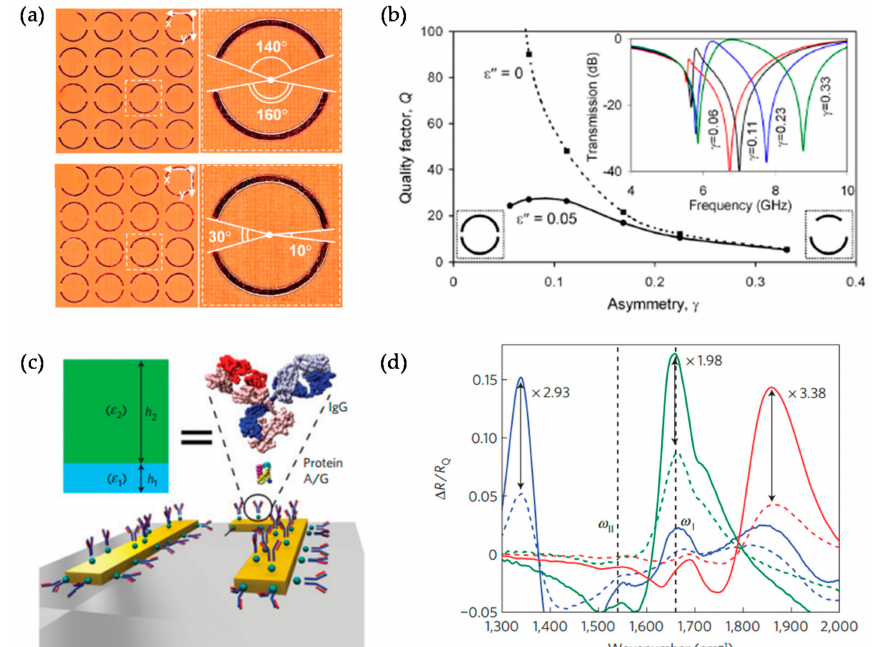
Figure 6. ( a ) Planar MMs with asymmetric split copper rings. The dashed boxes indicate unit-cell structure; ( b ) Quality factor of “trapped-mode” resonance as a function of the particle asymmetry γ , defined as the relative difference of the arcs’ lengths; ( c ) Schematic representations of proteins’ mono- and bilayers binding to the metal surface and the equivalent dielectric model; ( d ) Experimental spectra before (dashed lines) and after (solid lines) binding of IgG antibodies to three different Fano-resonant asymmetric MMs substrates immobilized by the protein A/G. Reprinted ( a , b ) with permission from Reference [115]. Copyright (2007) by the American Physics Society. Reprinted ( c , d ) by permission form Macmillan Publishers Ltd.: (Nature Materials) (Reference [123]), copyright